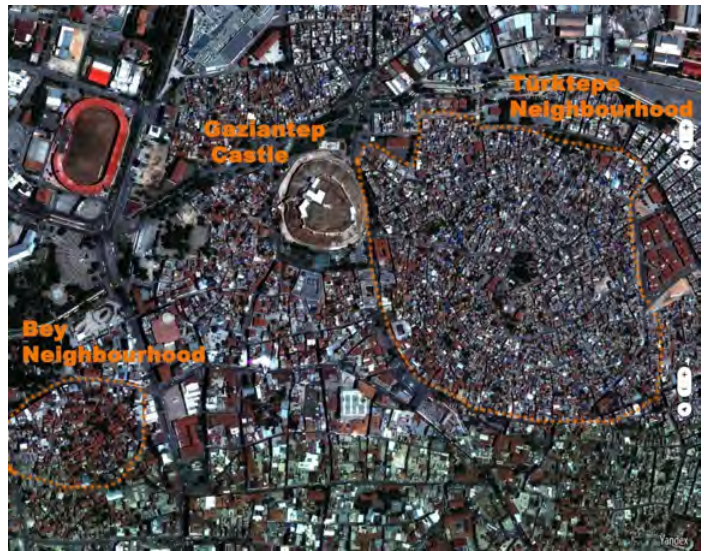
Figure 3. Gaziantep City Satellite View (Yandex, 2018)